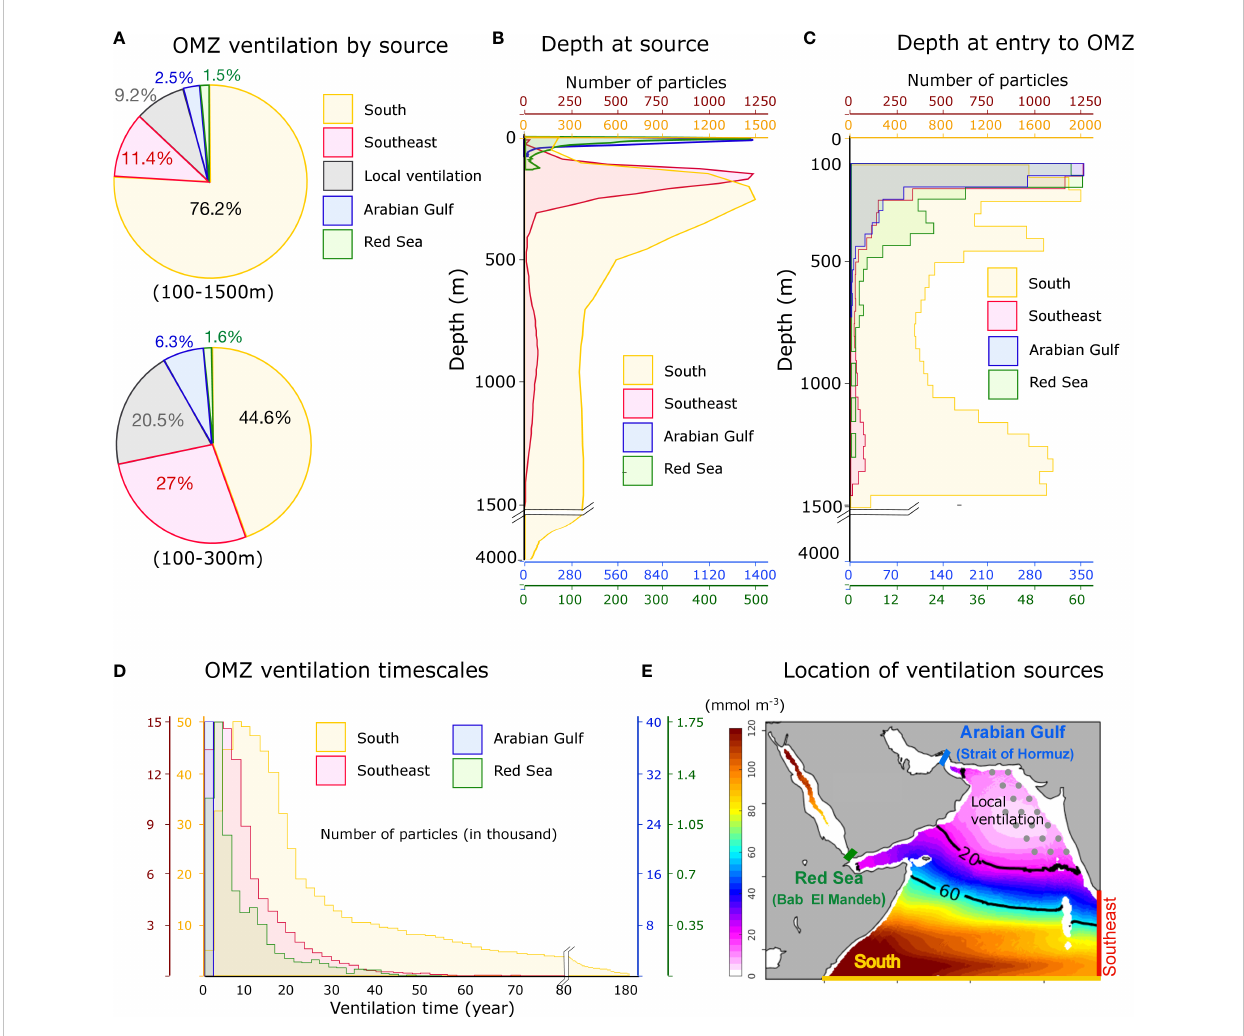
FIGURE 2 Arabian Sea OMZ ventilation sources and timescales. (A) Contributions of different source waters to the ventilation of the Arabian Sea OMZ (100- 1500 m) and its upper part (100-300 m). The OMZ waters are linked through Lagrangian tracking to fi ve potential sources associated with fi ve sections shown in (E) : south (at 5°N), southeast (at 78°E), the Arabian Gulf (Strait of Hormuz), the Red Sea (Bab El Mandeb) and the local ventilation (winter convection). (B, C) Particle depth at source (B) and at entry to the OMZ (C) associated with different remote sources. (D) Frequency distribution of OMZ ventilation timescales (in year) associated with different remote sources. Note that given the differences in the number of particles associated with each source, different sources are shown on different vertical axes in (B – D) . (E) Location of the entry sections where source particles are intercepted. Grey circles indicate the area of local ventilation (where the OMZ core gets in contact with the winter mixed layer). Color shading shows annual mean O 2 (in mmol m -3 ) averaged between 250 and